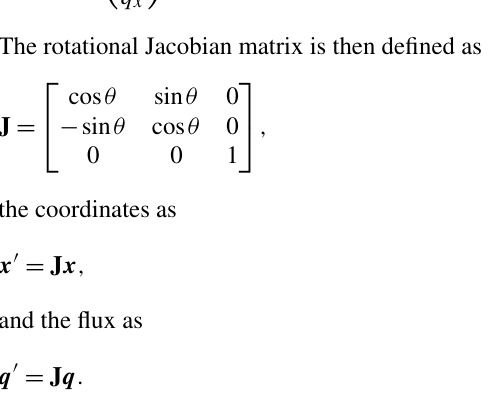
Figure 2. Schematic showing the rotation of the coordinate system to determine angles θ and φ